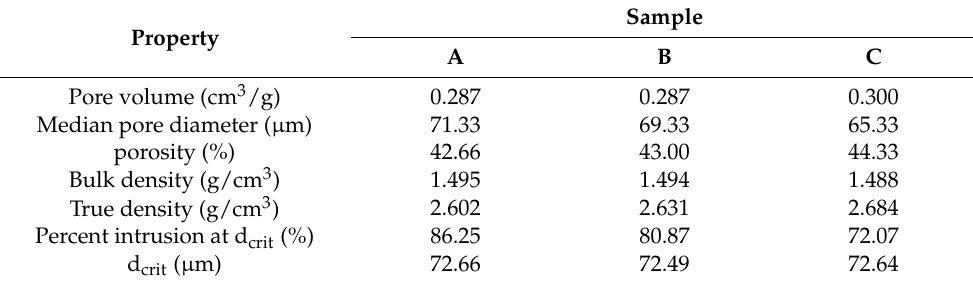
Table 5. Results of the mercury porosimetry measurements of the Furan samples with varying grain size distributions.